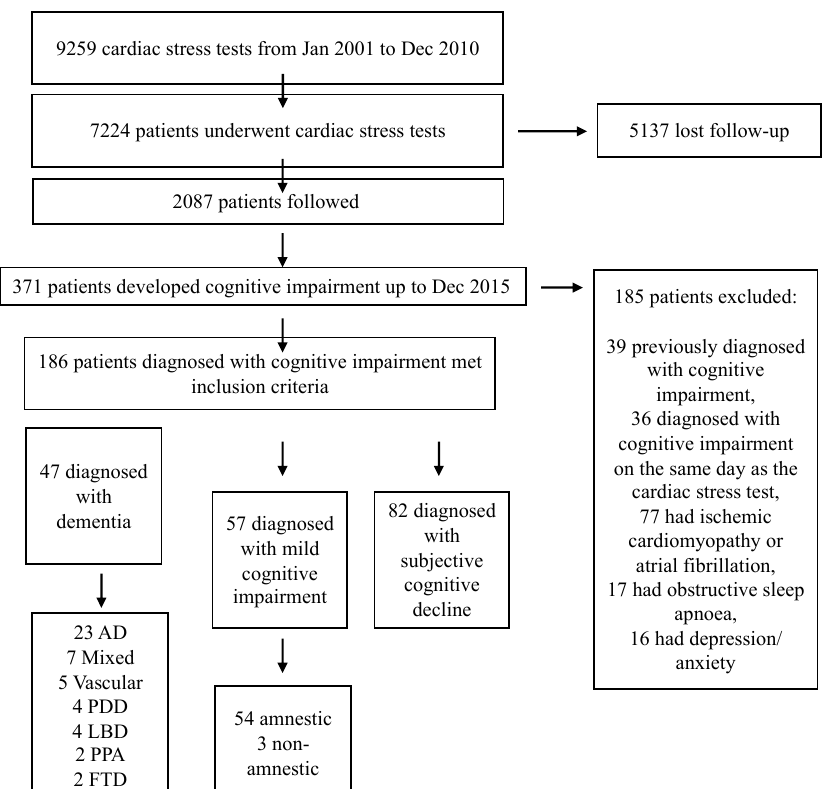
Figure 1. Flow diagram summarizing each stage of the study. AD, Alzheimer’s disease; FTD, frontotemporal dementia; LBD, Lewy bodies disease; PDD, Parkinson’s disease dementia; PPA.